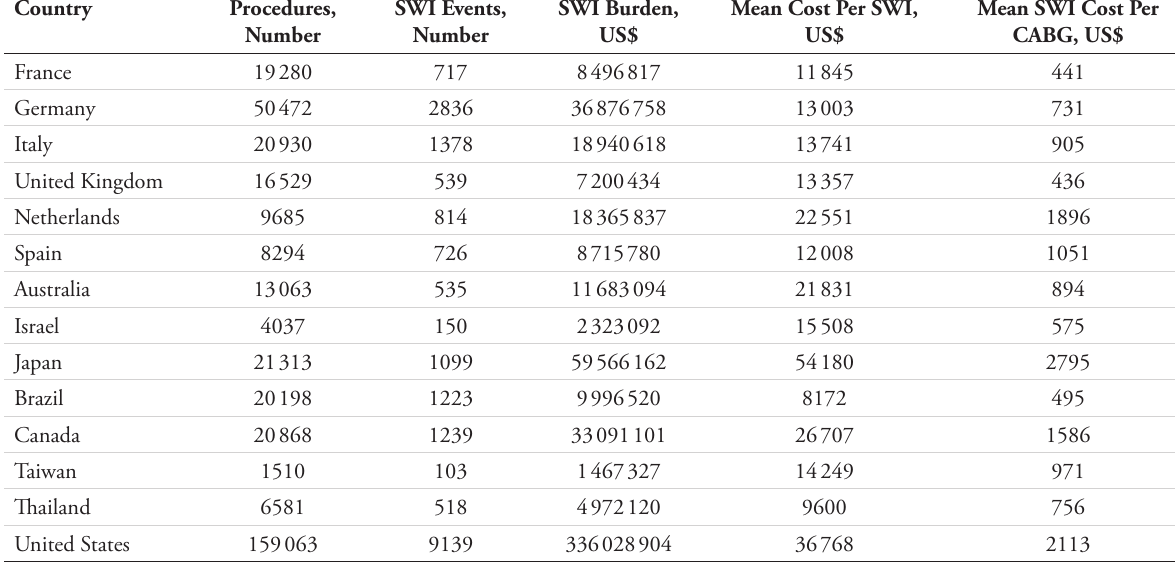
Table 1. Burden of CABG-Related SWIs by Country with Base Case Parameters Country